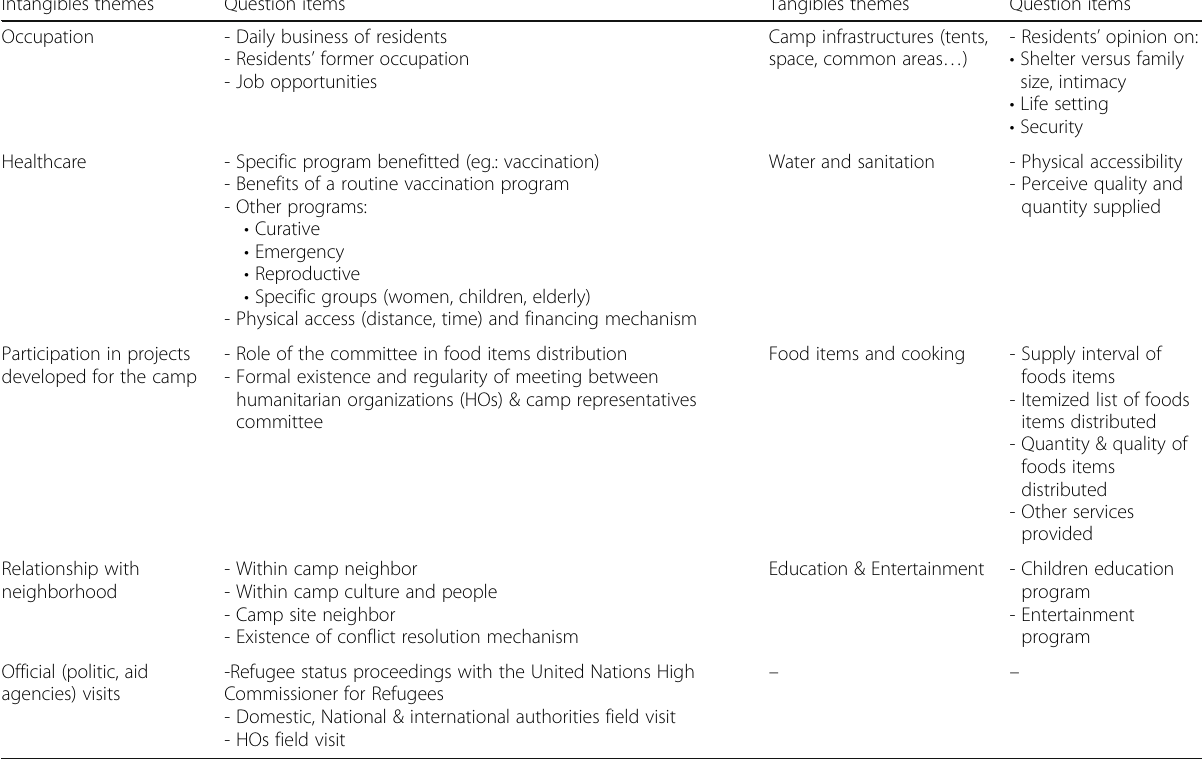
Table 1 Themes approached with Mentao camp refugee